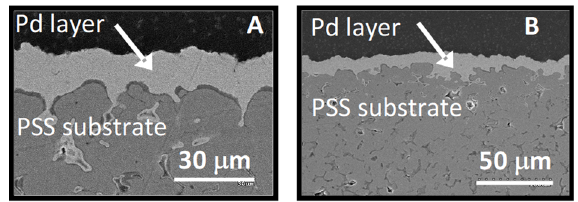
Figure 6. SEM images of the cross section of the oxidized Pd/PSS-700 ( A ) and the coated Pd/PSS- ZrO 2 ( B ) membranes.